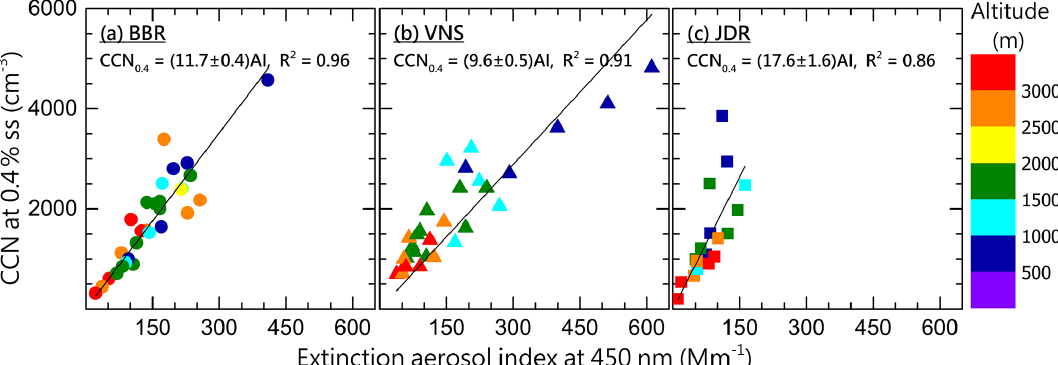
Figure 12. Association between the extinction AI at 450nm and CCN number concentration at 0.4% supersaturation for the (a) eastern (BBR), (b) central (VNS) and (c) western (JDR) IGP regions. The colour indicates the altitude of measurement. The solid lines represent the linear least-squares fit to the points for each region. Regression slopes and squared correlation coefficients are written in each panel.